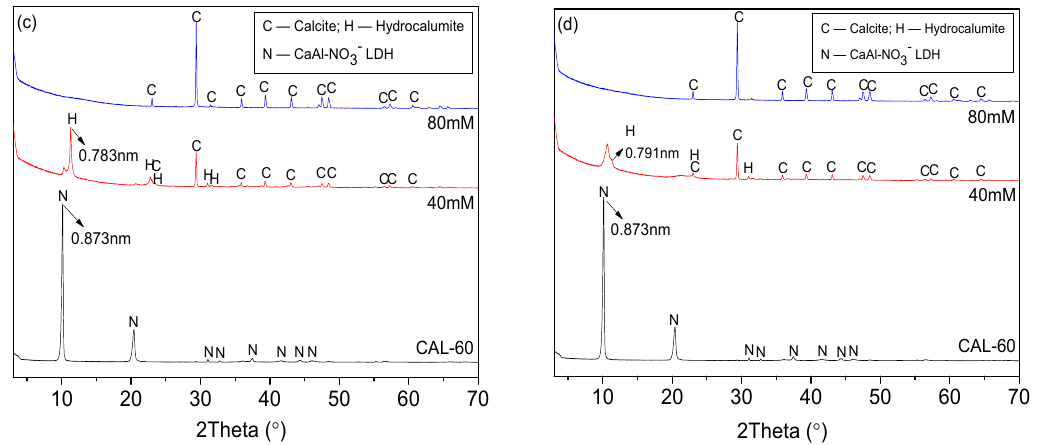
Figure 9. XRD patterns of solid phases after reaction by CAL-60 sample and 80 mM NaCl solution with different interference anions ((a) OH − ; (b) SO 42 − ; (c) CO 32 − ; (d) OH − and SO 42 − and CO 32 − ).